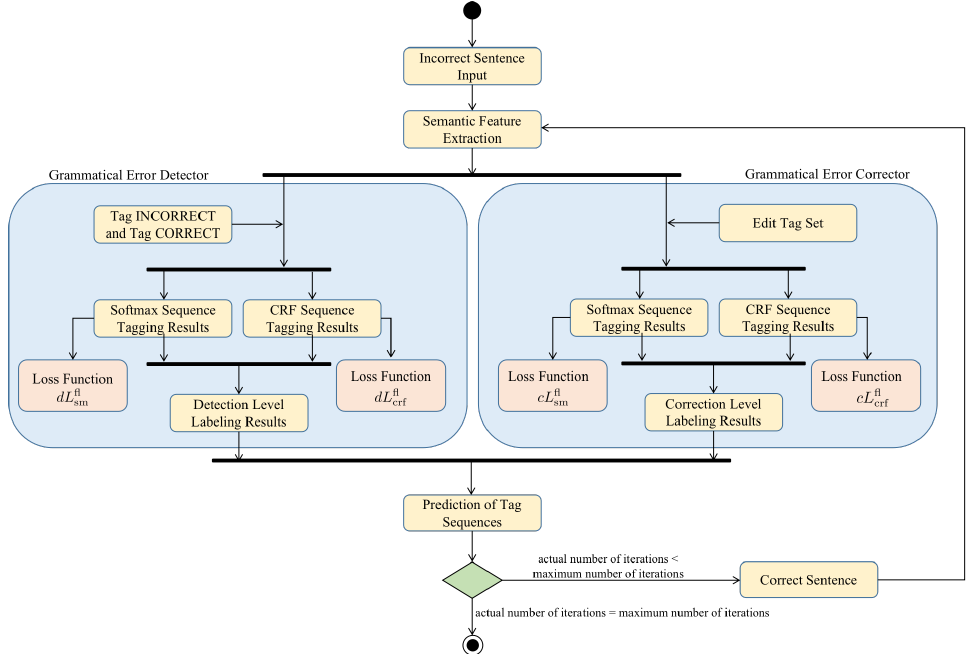
Figure 3. The activity diagram of the joint focal loss